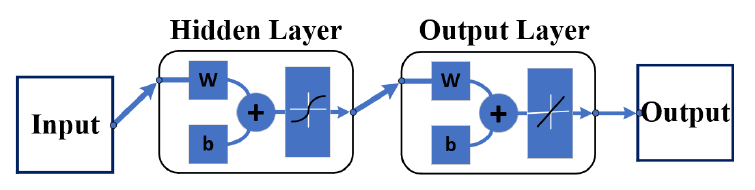
Figure 5. Structure of a conventional BP neural